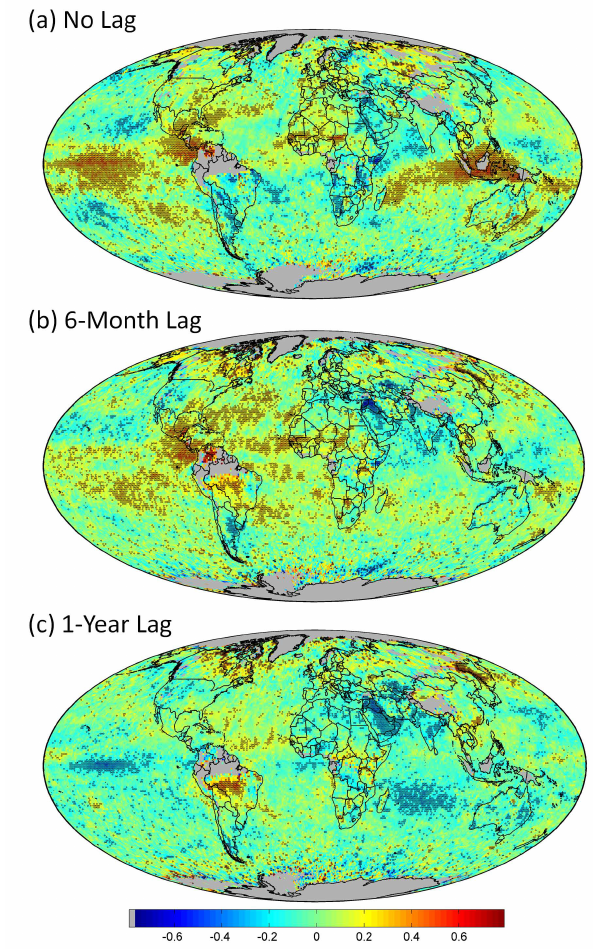
Fig. 3. Correlation coefficients of SeaWiFS deseasonalized monthly AOD anomaly with the multivariate ENSO index (MEI) (a) from the same month (no lag), (b) leading by 6 months, and (c) leading by 1 yr. Dots indicate significance at 95% confidence level. Regions shaded in grey indicate insufficient aerosol sample